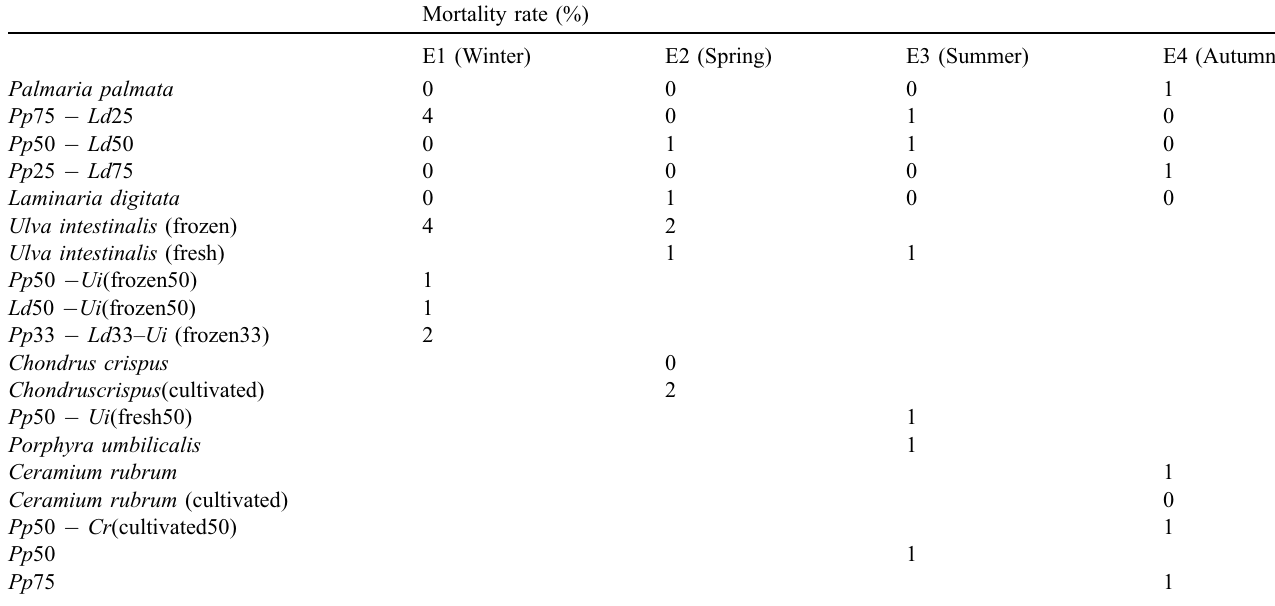
Table 3. Quarterly mortality rate for each diet by testing period: Pp : Palmaria palmata , Ld : Laminaria digitata , Ui : Ulva intestinalis , Cr : Ceramnium rubrum , Pp 25 (cid:3) Ld 75: a diet composed of 25% P. palmata and 75% L. digitata . Pp 75%: diet consisting of 75% of the amount of P. palmata consumed when supplied ad libitum